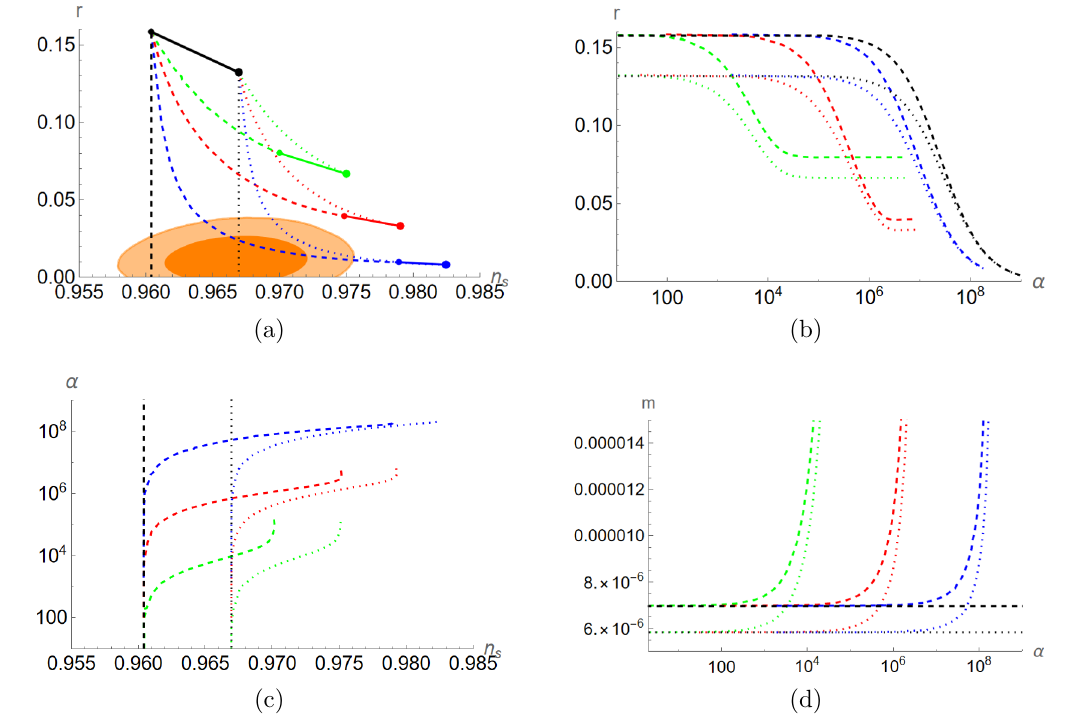
Figure 2. The observables r vs. n s (a), r vs. α (b), α vs. n s (c) and m vs. α (d) for the model in (3.1) with n = 3 / 2 (green), n = 7 / 4 (red), n = 31 / 16 (blue) and n = 2 (black) for N e = 50 (dashed) and N e = 60 (dotted). The scalar amplitude A s is fixed to its observed value. For reference, we also plot the predictions for N e ∈ [50 , 60] of the corresponding asymptotic solutions in eqs. (3.15)–(3.17) (same color code, continuous line) and of quadratic inflation (black). The orange areas represent the 1,2 σ allowed regions coming from the latest combination of Planck, BICEP/Keck and BAO data